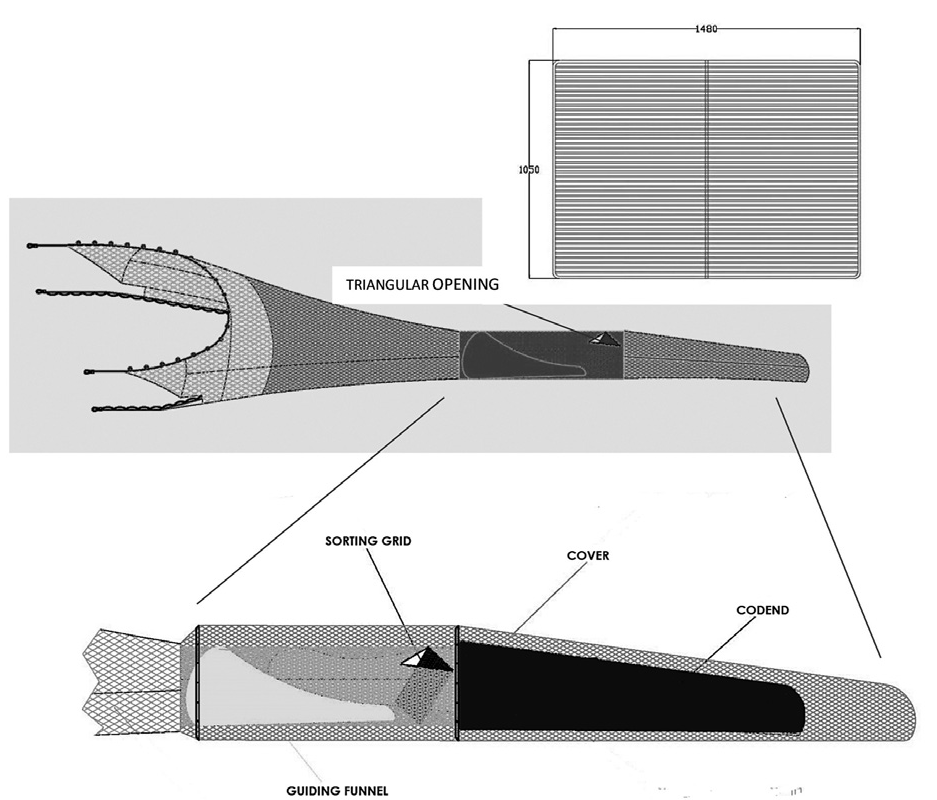
Fig. 2. – Technical drawing of the Nordmøre grid used in the experimental